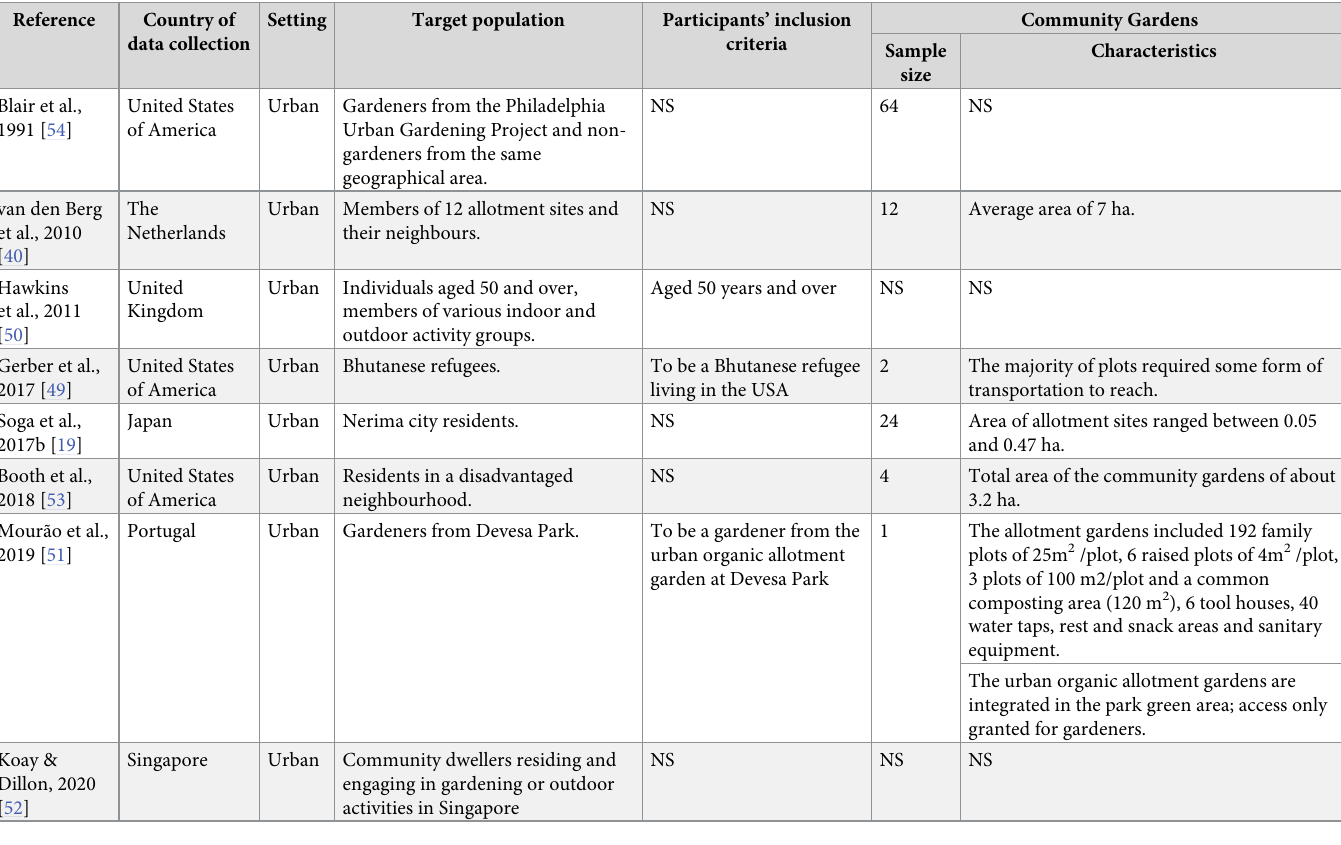
Table 1. Characteristics of the community gardens described in the studies included in this systematic literature